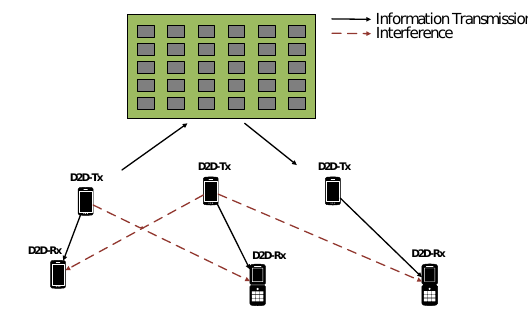
Figure 1. System model of the IRS-assisted D2D communica-